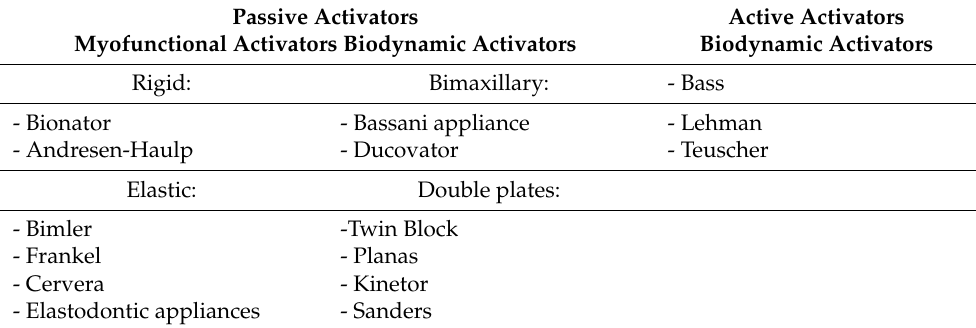
Table 9. A schematic summary of traditional functional